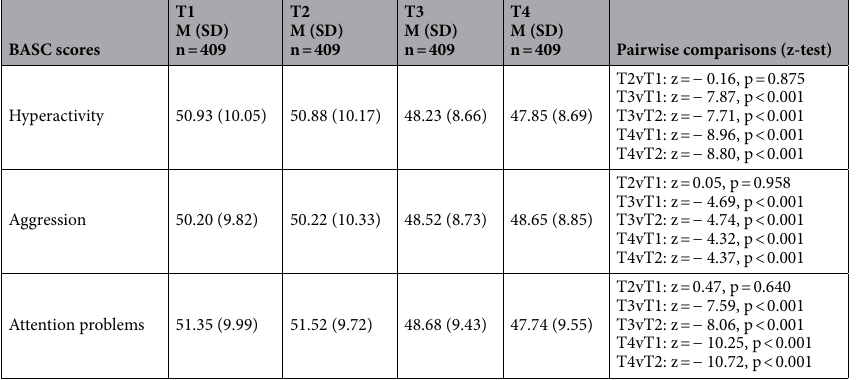
Table 2. Differences in BASC scores between the waitlist, active ENGAGE period, and two months following the active ENGAGE period.